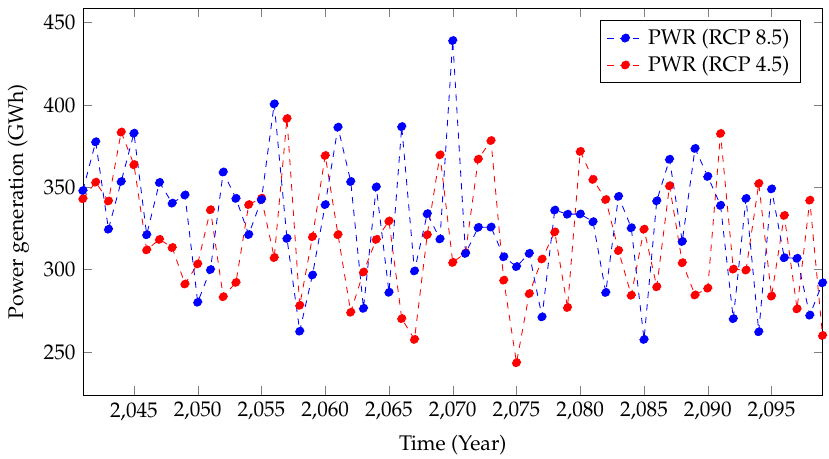
Figure 9. Power generation prediction from year 2041 to 2099 Figure 8. Power generation predictions from 2041 to Table 3. RMSE for training and testing